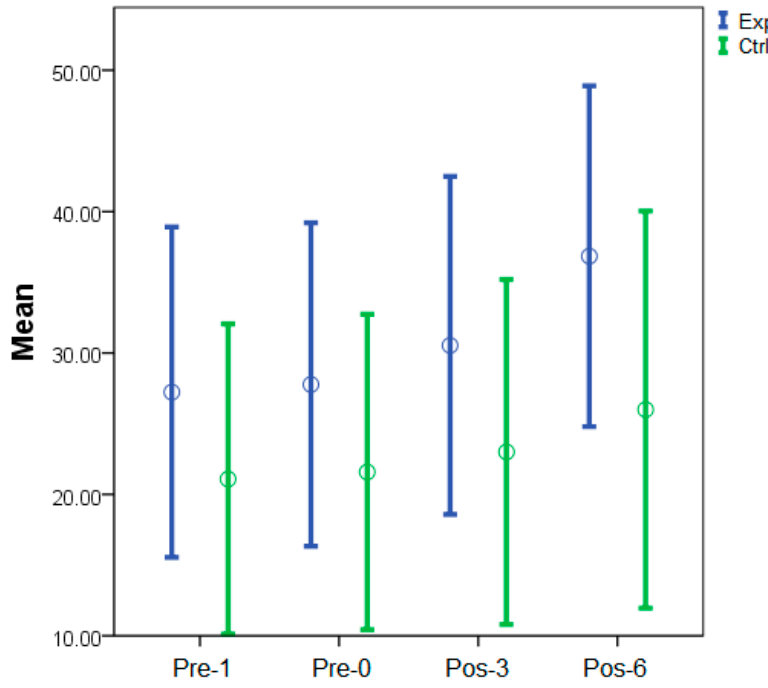
Figure 4. Sequential changes in mean FMA-UE scores in the study groups. Mean values and ± 1 stan- dard error were displayed. Exp.: experimental group; Ctrl.: control group.